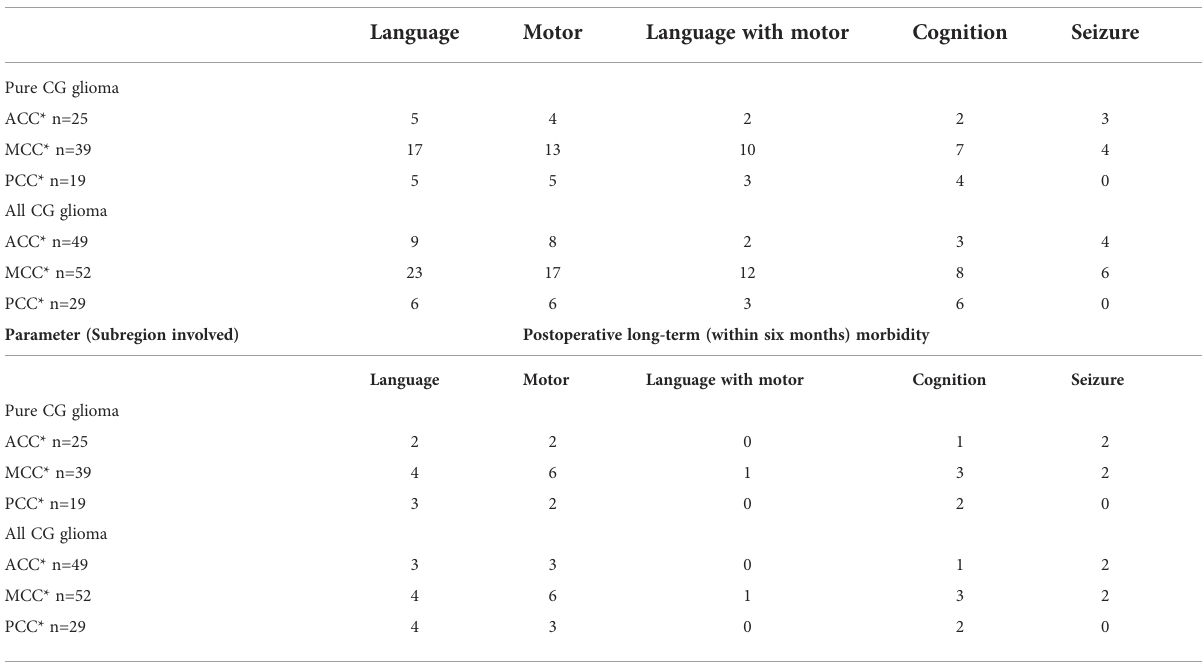
TABLE 4 Summary of relationship between function de fi cits and distribution of sub-region. Parameter (Subregion involved)